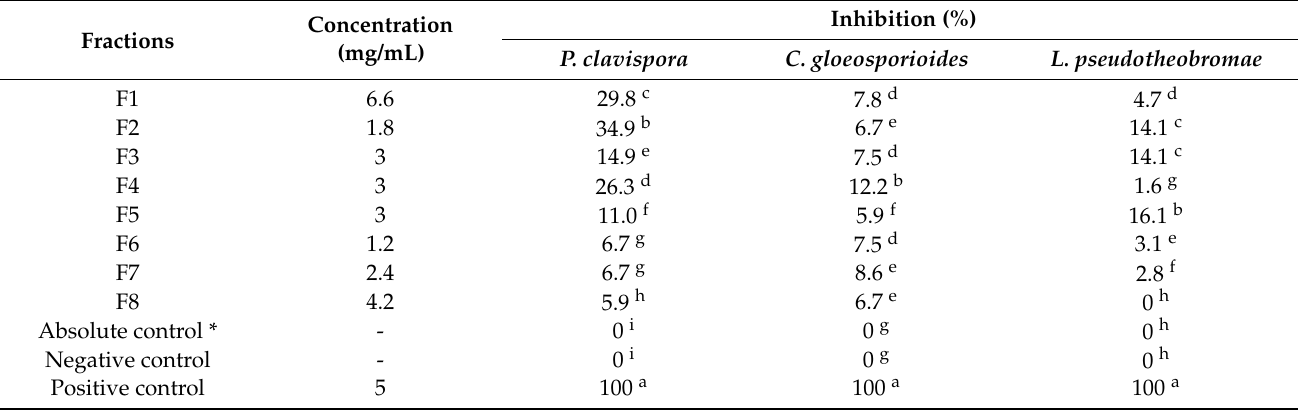
Table 4. Percentage of mycelial growth inhibition of P. clavispora , C. gloeosporioides and L. pseudotheobromae by fractions from the M4LS crude extract of A. porophyllum